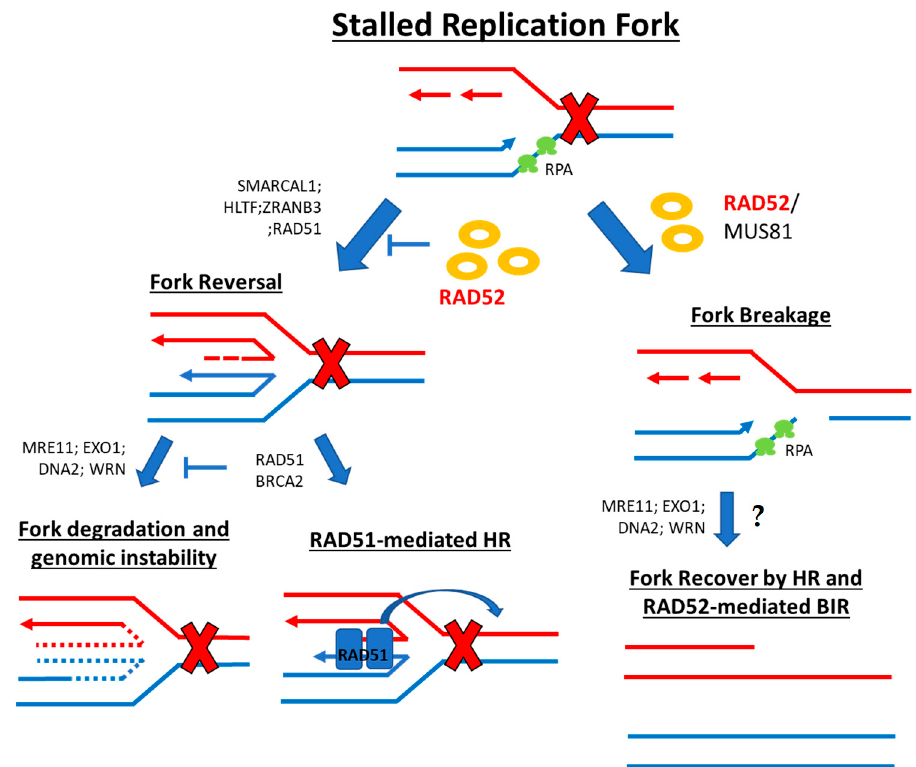
Figure 2. Schematic representation of stalled replication fork steps involving RAD52. ( Left ): RAD52 acts as a gatekeeper for the replicative fork to prevent unscheduled MRE11-mediated degradation and to facilitate enzyme loading only when required. ( Right ): RAD52 mediates the fork break mechanism for stall resolution and may mediate fork recovery through BIR.